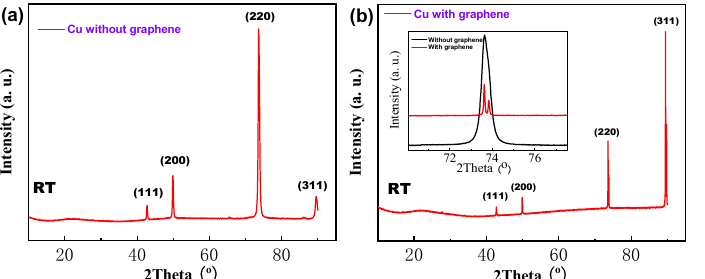
Figure 4. Room-temperature XRD patterns of ( a ) the pristine copper foil and ( b ) graphene modified copper foil.